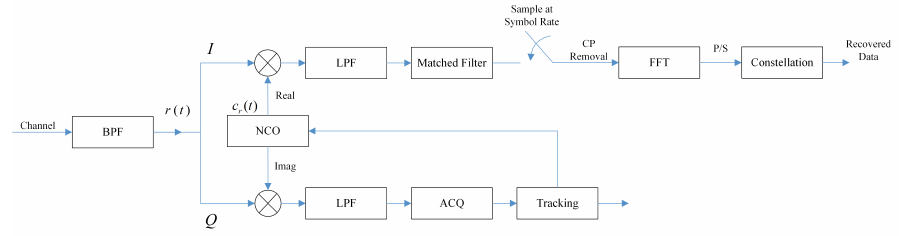
Figure 3. Block diagram of designed